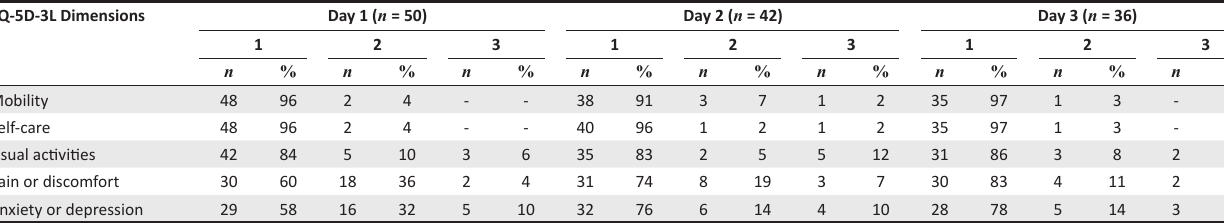
FIGURE 2: Box and whisker plot of caregivers’ EQ-5D-3L scores over time. TABLE 2: Caregivers dimension scores over the 3 days. EQ-5D-3L